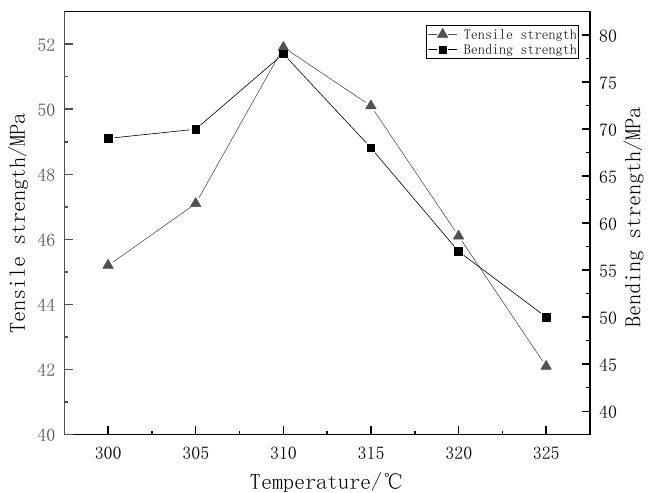
Figure 9. Effect of different moulding temperatures on the mechanical properties of glass fibre reinforced polyphenylene sulphide composites.